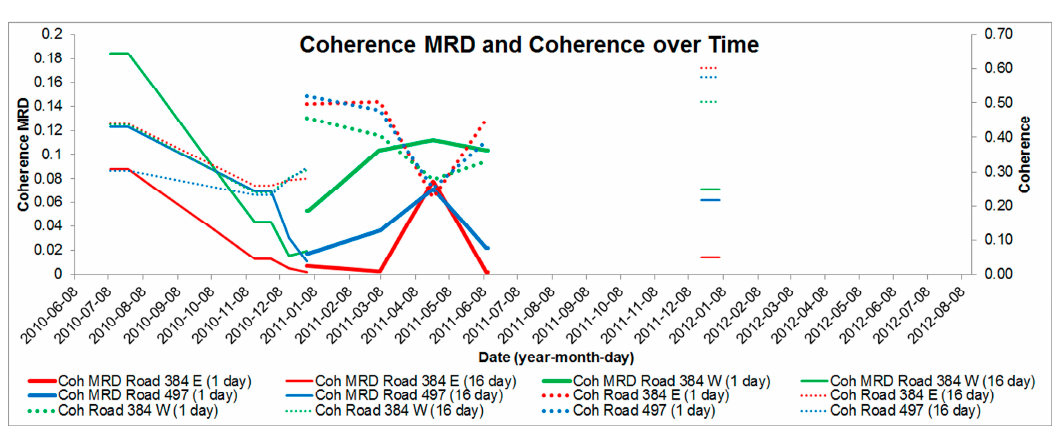
Figure 40. Graph showing contrast of coherence residues, as described in Figure 39, and coherence over each residue (in dotted lines). The coherence values are provided both for the master and the slaves of InSAR pairs. Where a master is also a slave, it takes the value of the slave.